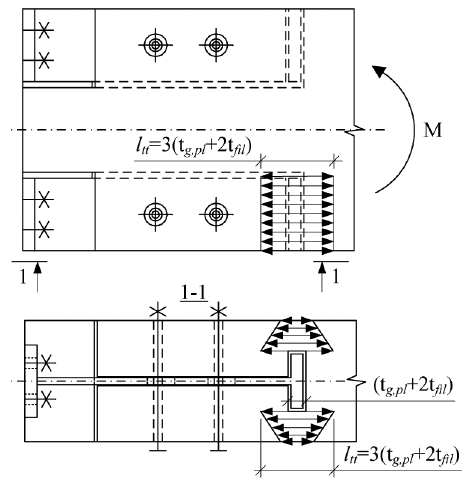
Fig. 5. Deformation distribution in timber, in the tension zone of the